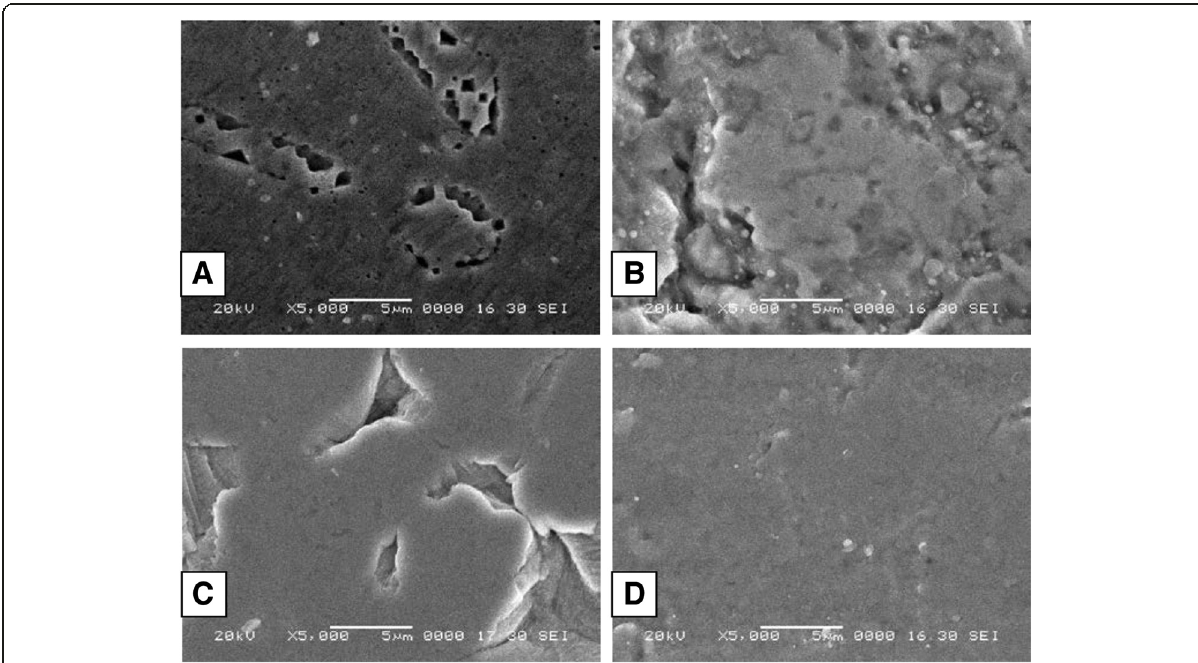
Fig. 3 SEM microphotographs of stainless steel bracket slot from different manufacturers (×5000 magnification): a 3M Unitek, b Ormco, c Ortho Organizers, and d American